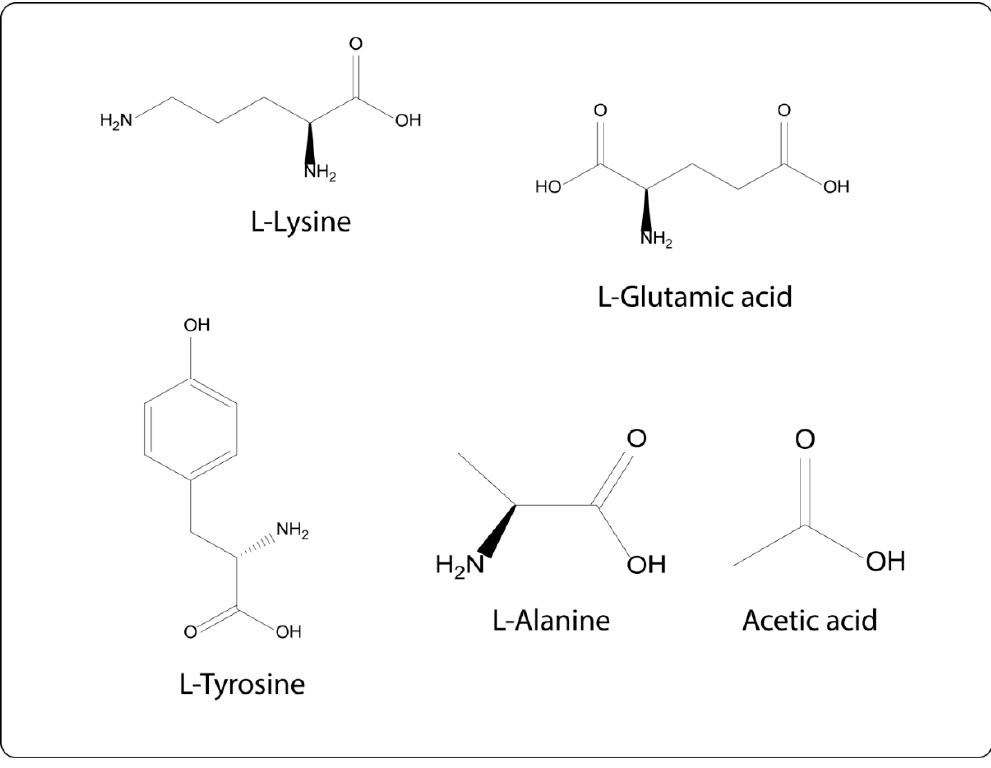
Figure 13. Synthetic peptides of Cop1 structure.